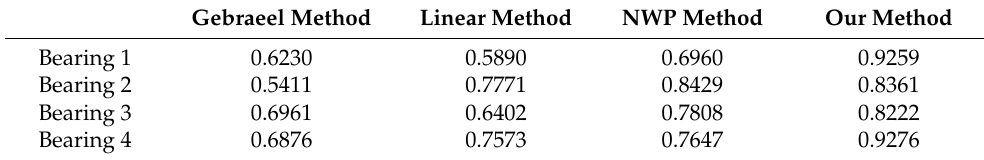
Table 6. FEMTO-ST CRA